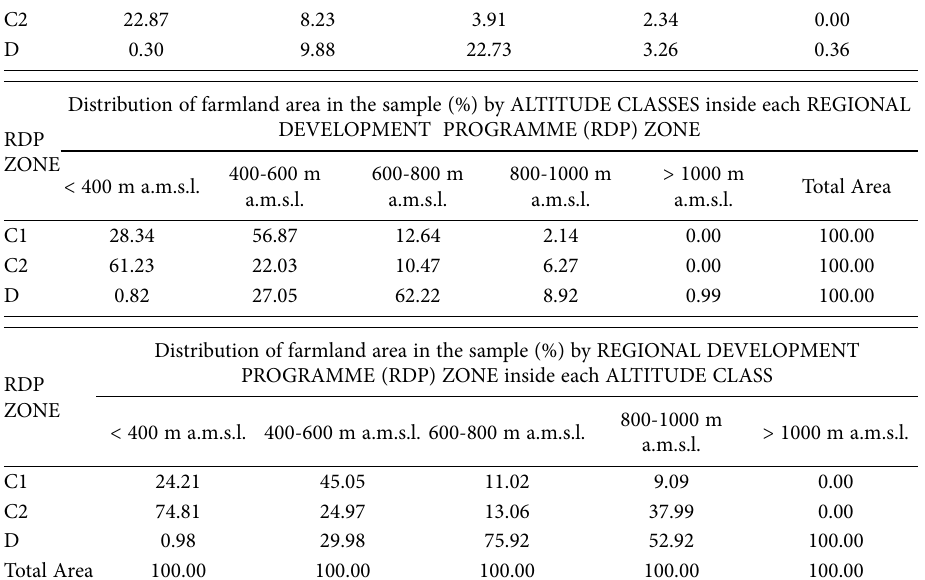
Table 7. Mugello - Distribution of farmland areas in RDP zones according to the class of altitude (meters above medium sea level). Distribution of farmland area in the sample (%) by ALTITUDE CLASSES and REGIONAL RDP DEVELOPMENT PROGRAMME (RDP) ZONES ZONE